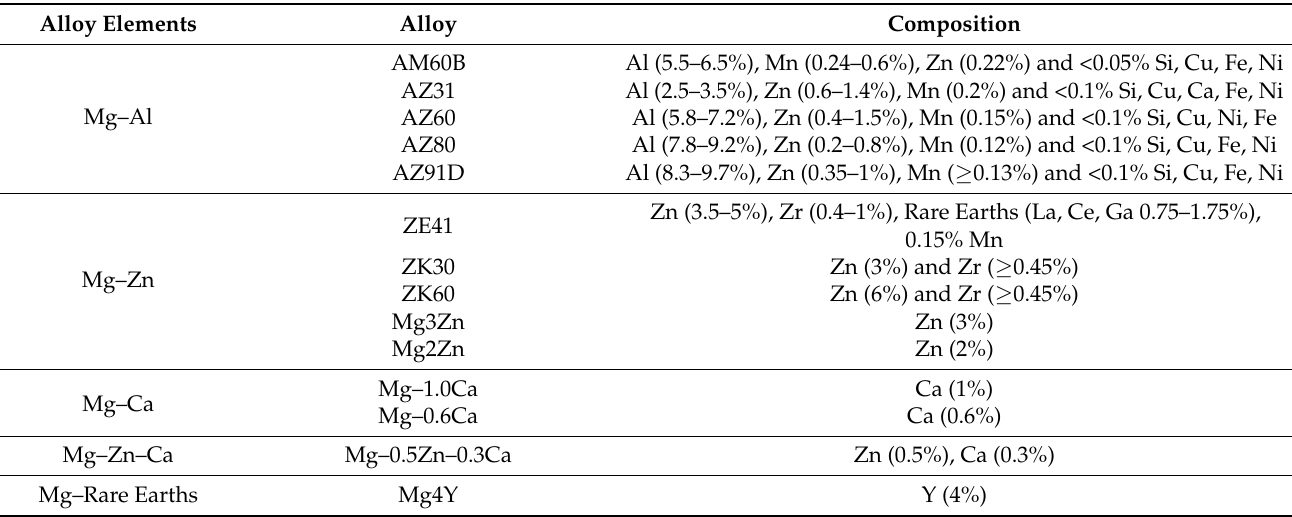
Table 3. Composition of different magnesium